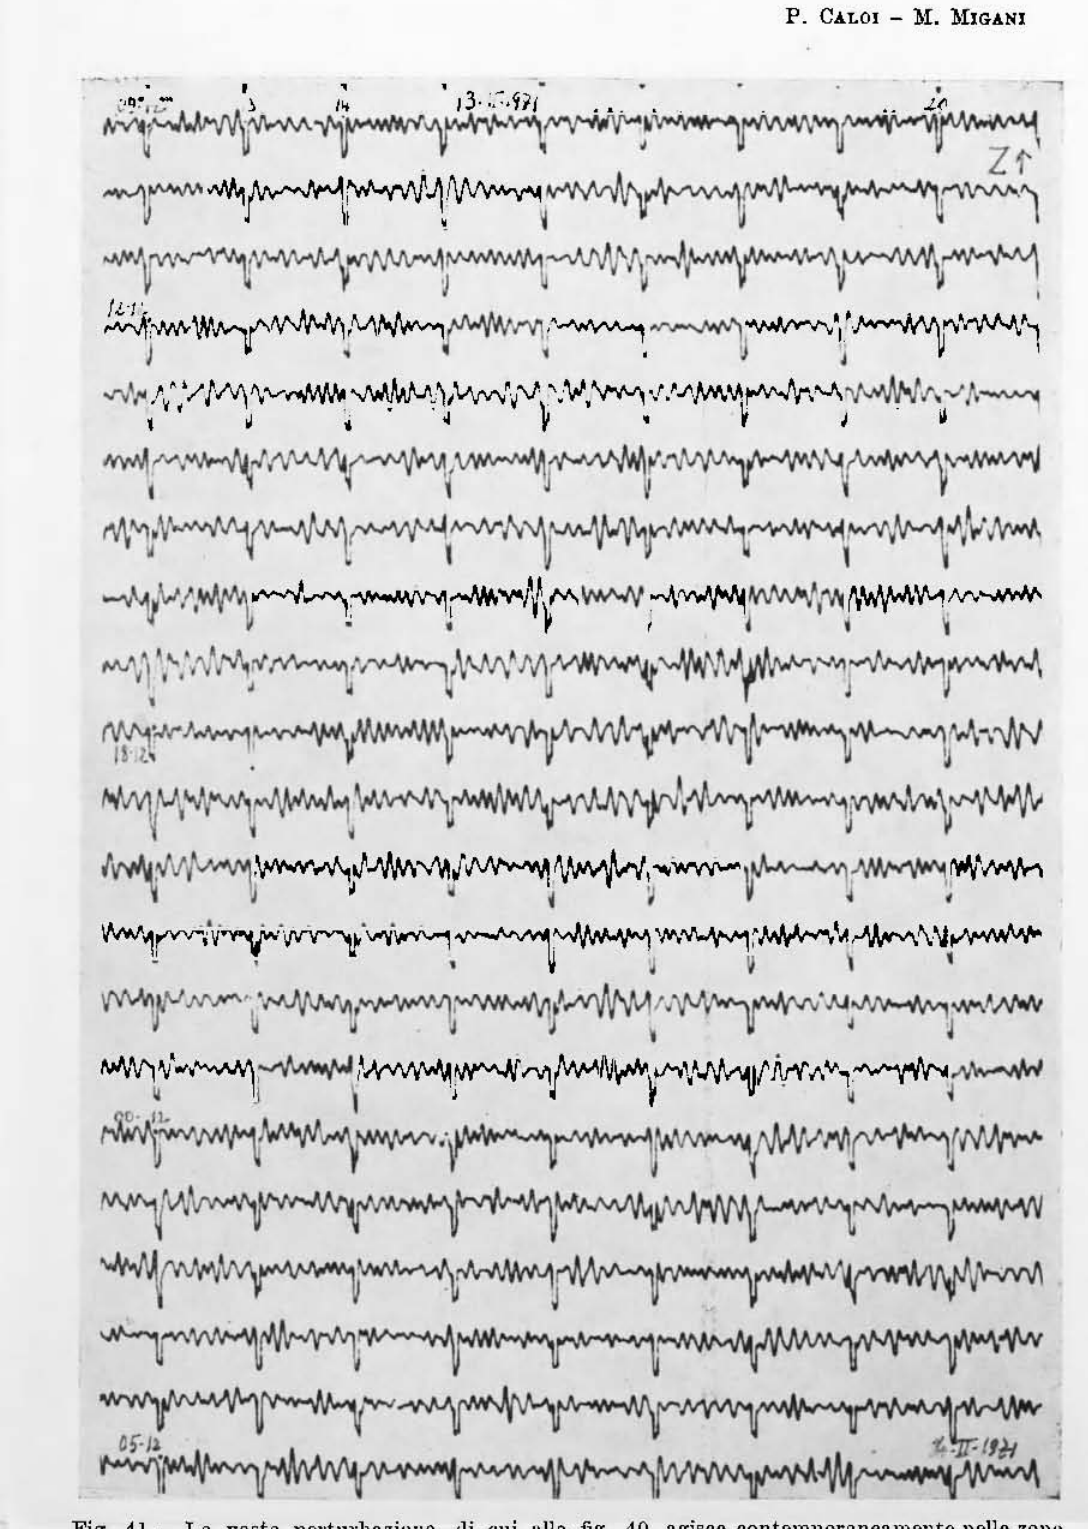
Fig. 41 - La vasta pet'turbazione, di cui alla fig. 40, agisce contemporaneamente nelle ZOIW di mare presso le coste scandinave e presso le coste oecidentali delle isole britanniche: di qui l'alternarsi dei gruppi di rnierosismi, con periodi dell'ordine di 5,5 see e 8·8,5 see, propri della prima e della seeonda zona, rispettivamente. Con lo spostamento verso S\V della zona perlur. bante ed il successivo investimento della zona di mare ad ovest dell'Irhmda (figg. 44.45) i mi· erosismi di 8-8,5 see ca a Uppsala prevalgono nettamente, se non esclusivamente (fig. 42). Fig. 41 - The wide perturbation sbown in fig. 40 acts simultaneously in the sea area near tbe Seandinavian coast and near the "Test eoast of the British !sles, wllieb explains the alternation of groups of rnieroaeisrns with periods in the order of 5,5 see and 8·8,5 sec, peculiar to the former and to tbe latter area, respectively. \Vhen the disturbance area shifted toward SW and affeeted the sea strip \Vest of Ireland (figures 44 and 45), the 8·8,5 see rnieroseism8 prevail clearly, if not exclusively, at Uppsala (fig.